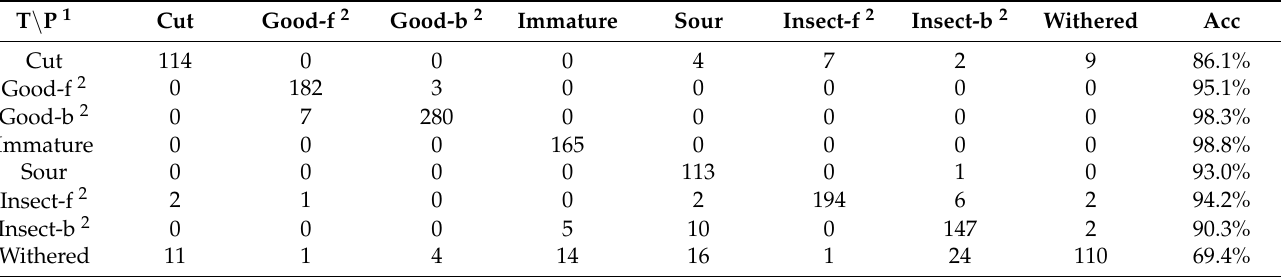
Table 7. Confusion matrix of the AlexNet-aj